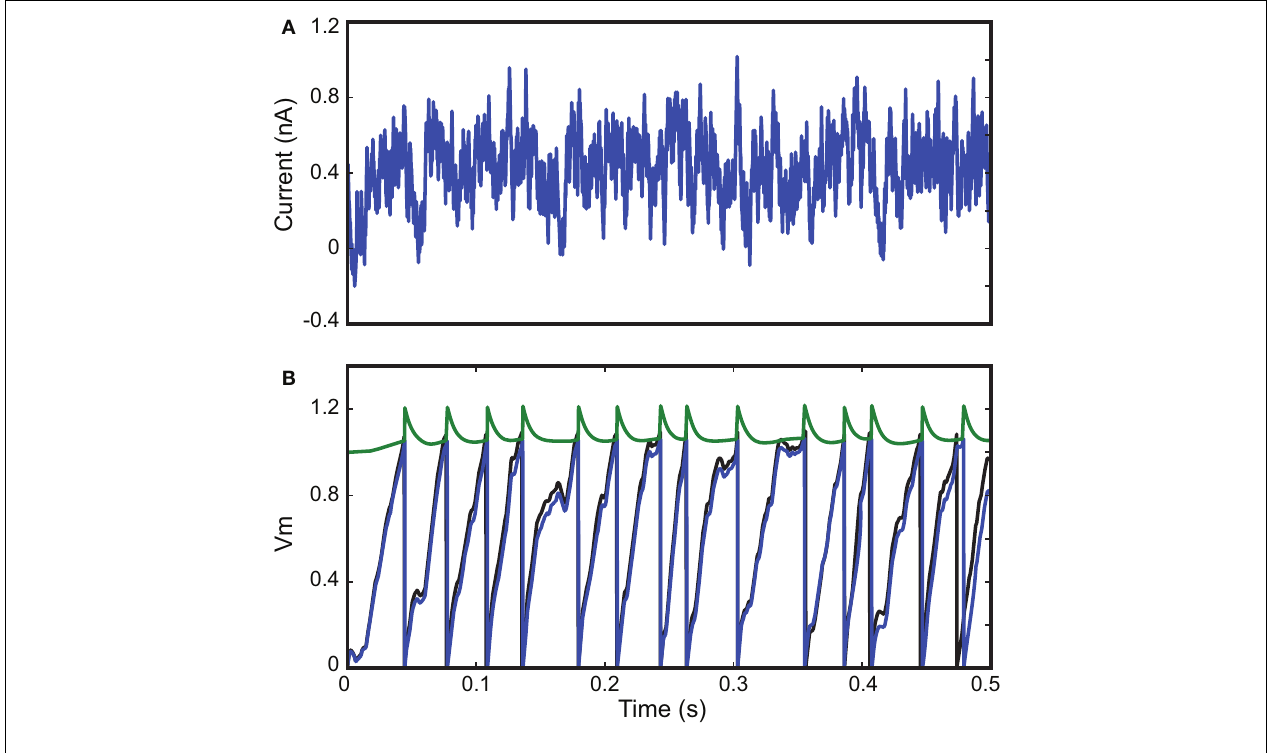
FIGURE 3 | Fitting a leaky integrate-and-fi re model with adaptive threshold. (A) A 500-ms fl uctuating current is injected into a leaky integrate-and-fi re neuron with adaptive threshold ( R = 3.4 × 10 9 A − 1 , = 10 ms, α = 0.15, a = 0.1). The output spike train is used as the τ = 25 ms, τ t target spike train for the fi tting procedure with the same model. (B) Results